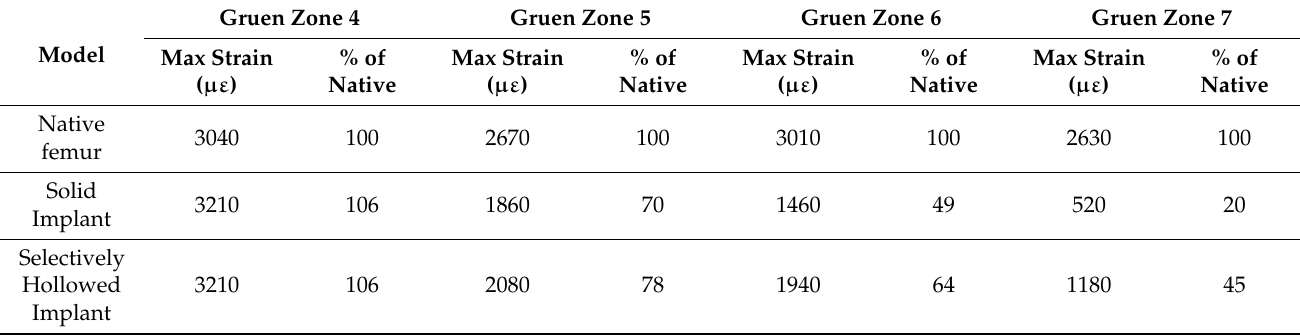
Table 3. Maximum surface bone strain and percentage of native bone strain for the selectively hollowed, solid implant and native femur for peak gait